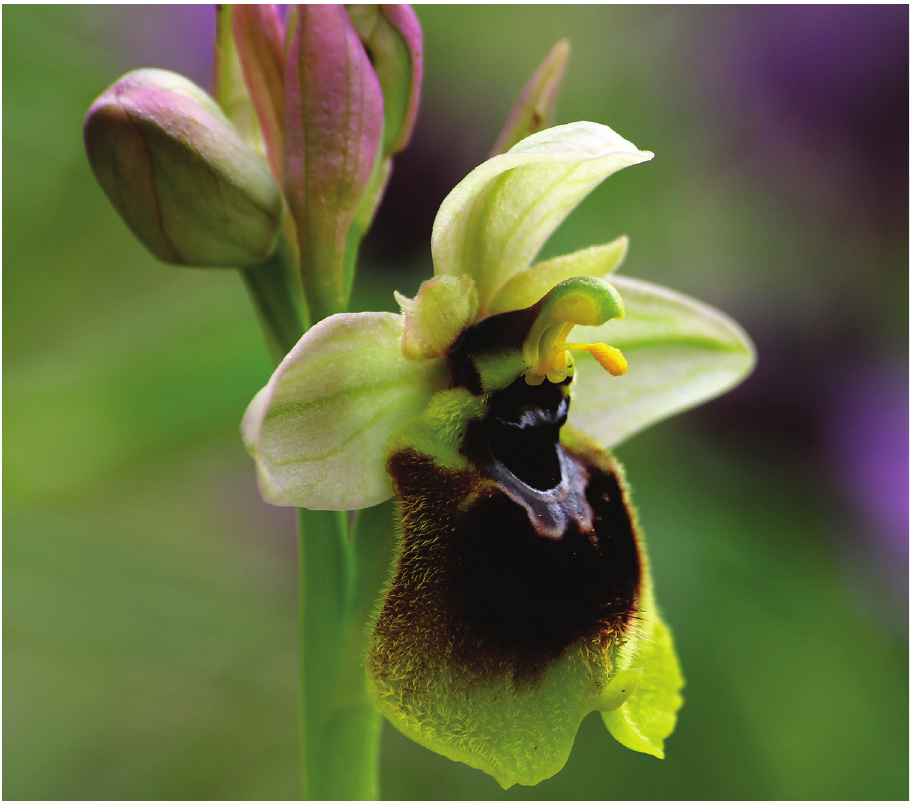
Figure 1. Flowers of Ophrys normanii . Photograph by V. Rodi.